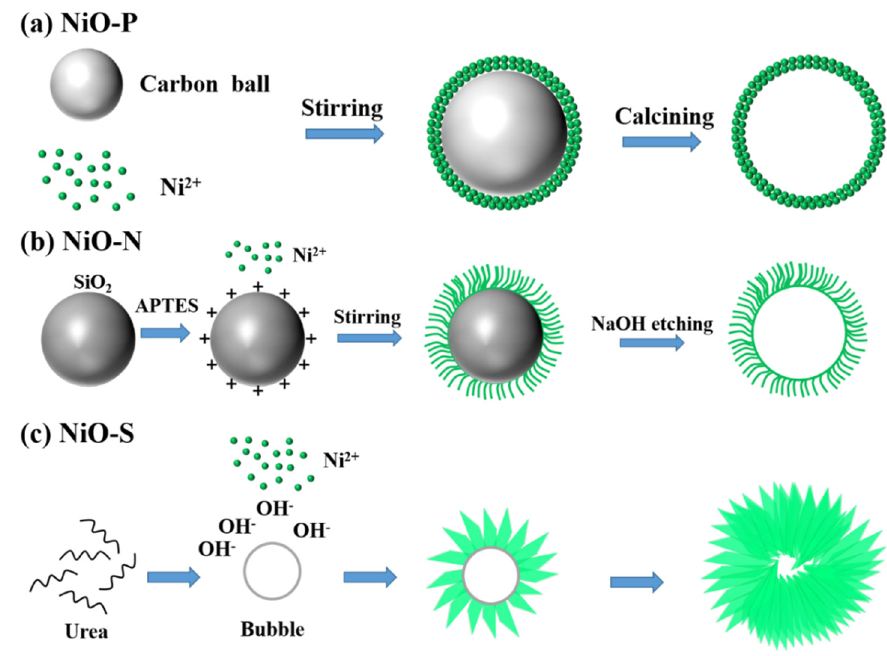
Figure 8. Schematic diagram of the formation process of ( a ) NiO-P, ( b ) NiO-N, ( c ) NiO-S.